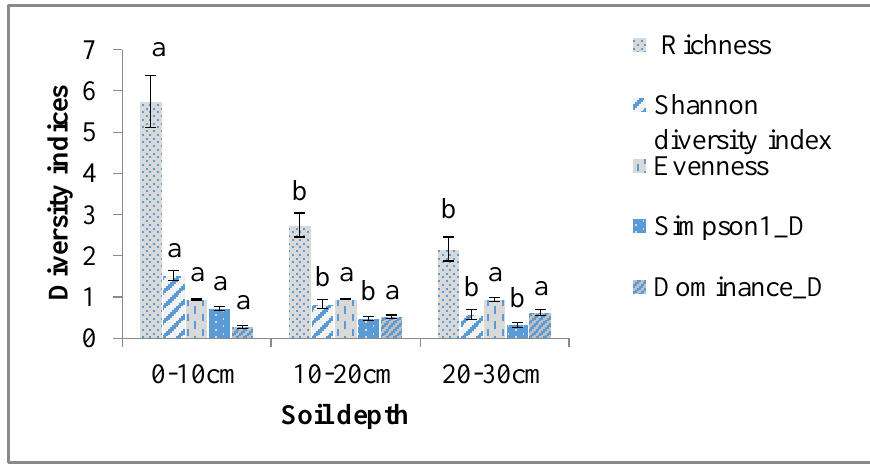
Figure 4. Effect of soil depth on SMI diversity. Different letters above the bars indicate significant differences among soil depth. Bars indicate mean ± SEM.